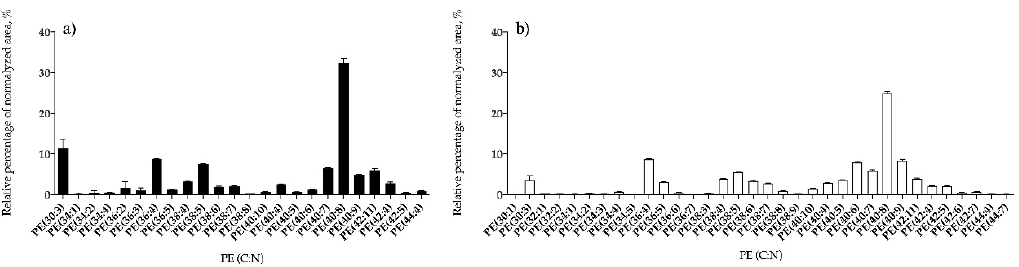
Figure 8. Relative abundance (RA) of lipid species of the phosphatidylethanolamine (PE) class identified in B. bifurcata ( a ) and S. muticum ( b ). The results are expressed as relative percentage after dividing the normalized peak area of each lipid species to the sum of normalized peak areas for all the lipid species within the class obtained after LC–MS analysis. Numbers in parentheses (C:N) indicate the number of carbon atoms (C) and double bounds (N) in the fatty acid side chains. The species with higher RA was PC (40:8) for both seaweeds.